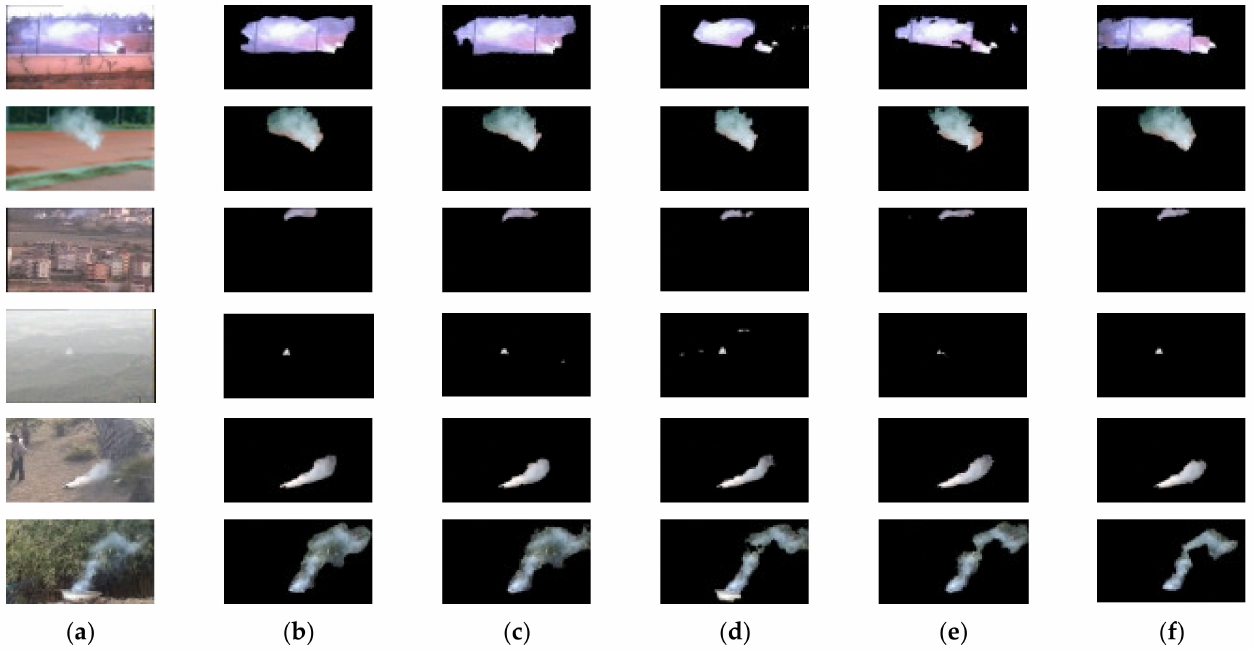
Figure 7. Output of each method from Dataset 3, from top row to bottom row, Video 1 to Video 6, respectively. ( a ) Input frame; ( b ) ground truth; ( c ) ours; ( d ) FCN; ( e ) RANet; ( f ) DeepLab